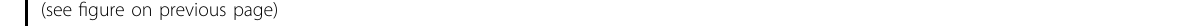
Fig. 4 Fibrogenic differentiation of mdx FAP cell states. a Experimental design to induce fi brogenic differentiation of mdx FAP cell states. GM = growth medium; FM = fi brogenic medium. b Bar plot presenting alpha-SMA-positive area per cell in each fi eld (n = 6). Statistical signi fi cance was evaluated using Two-way ANOVA. c Representative microphotographs of (b ). Immuno fl uorescence against alpha-SMA (yellow) and nuclei counterstaining (blue, Hoechst 33342). Scale bar 100 μ m. d – f Bar plots showing Col3a1 , Col1a1 (n = 3) and Timp1 (n = 4) mRNA expression. Following 5 days of differentiation samples were analysed by Real-Time PCR. Statistical signi fi cance was estimated through a Two-way ANOVA. g , h Bar plots showing Col3a1 and Col1a1 mRNA expression immediately after sorting (n = 3). Samples were analysed by Real-Time PCR using 2 - ΔΔ Ct comparative method. Tubulin mRNA was set as reference gene. Statistical signi fi cance was evaluated by Student ’ s t test. Data are presented as mean ±